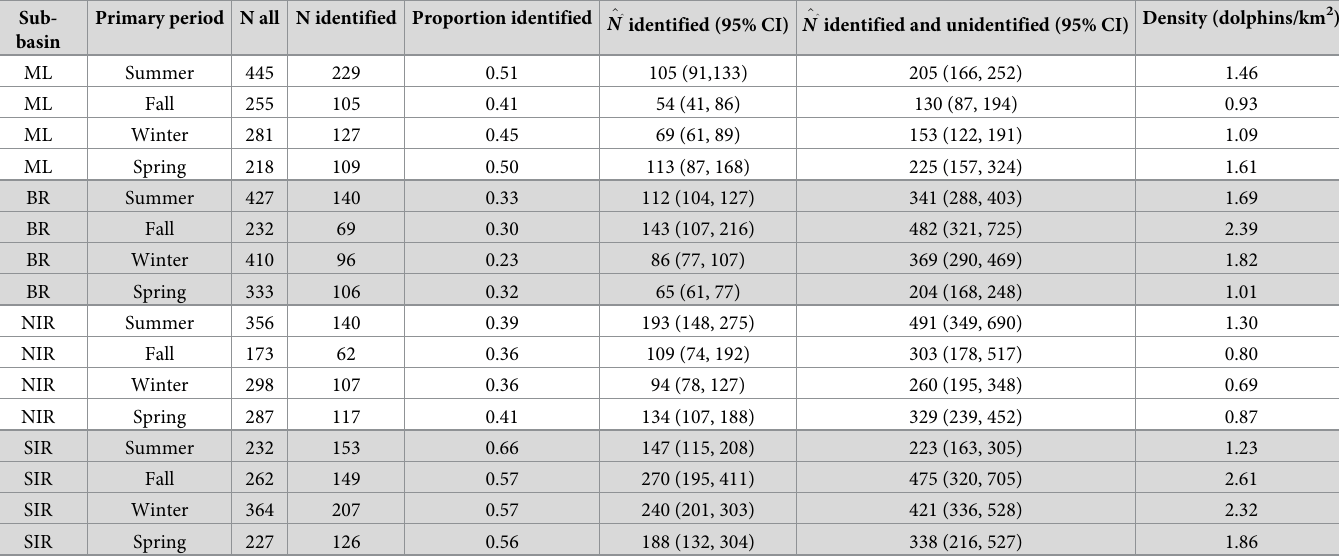
Table 6. Estimated abundance (95% CI) and density of bottlenose dolphins in the Indian River Lagoon sub-basins, by primary period during